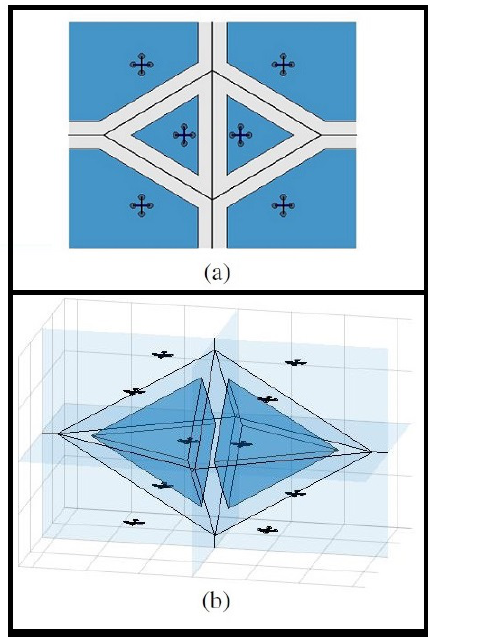
Figure 3. ( a ) The Voronoi diagram for six drones in 2D space. The Voronoi boundary edges are shown with solid black lines, and the buffered Voronoi cells are shaded in dark blue. ( b ) The Voronoi diagram for 10 drones in a collision-free configuration in 3D space. The Voronoi boundary ∂ V is shaded in light blue, and the buffered Voronoi cells ¯ V for two neighboring drones in the center are shown in dark